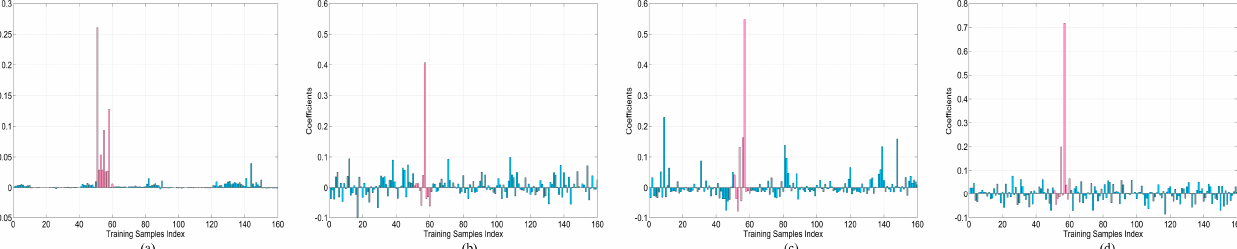
Figure 12. Representation coefficients of a test sample from class 6 in the Indian Pines data set using 10 training samples per class for the MFCART algorithm. ( a ) Spectral. ( b ) Gabor. ( c ) DMP. ( d ) LBP.